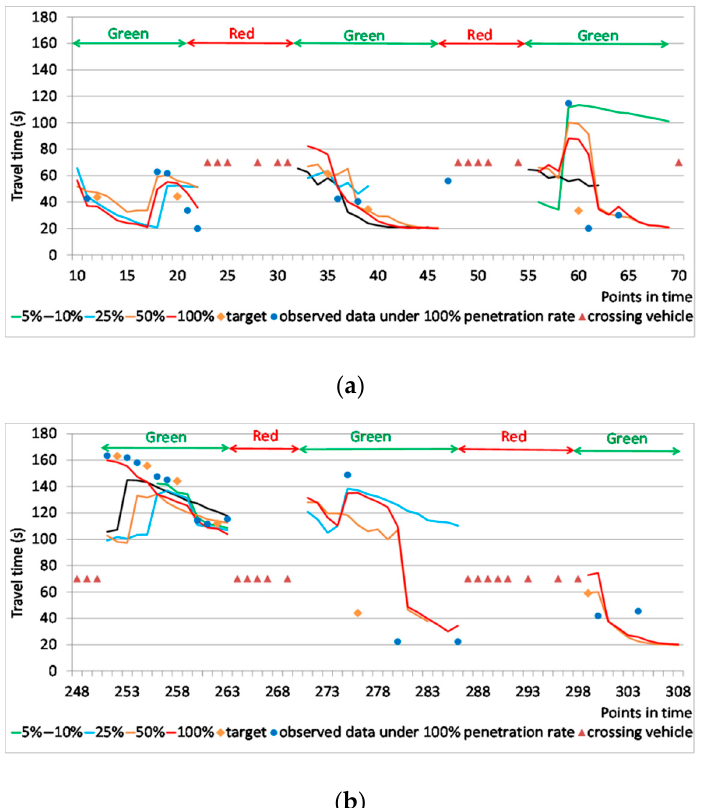
Figure 8. Predictions of the proposed model under different penetration rates: ( a ) Time points from 10 to 70; ( b ) Time points from 248 to 308.